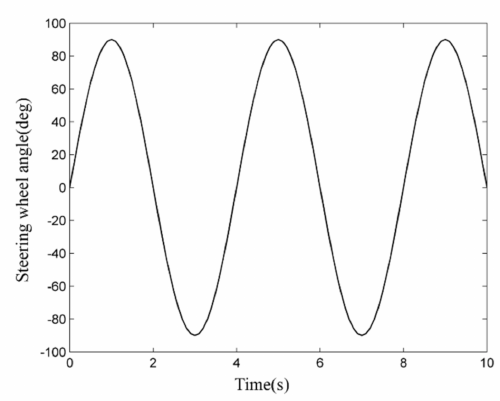
Figure 5. The front wheel steering angle